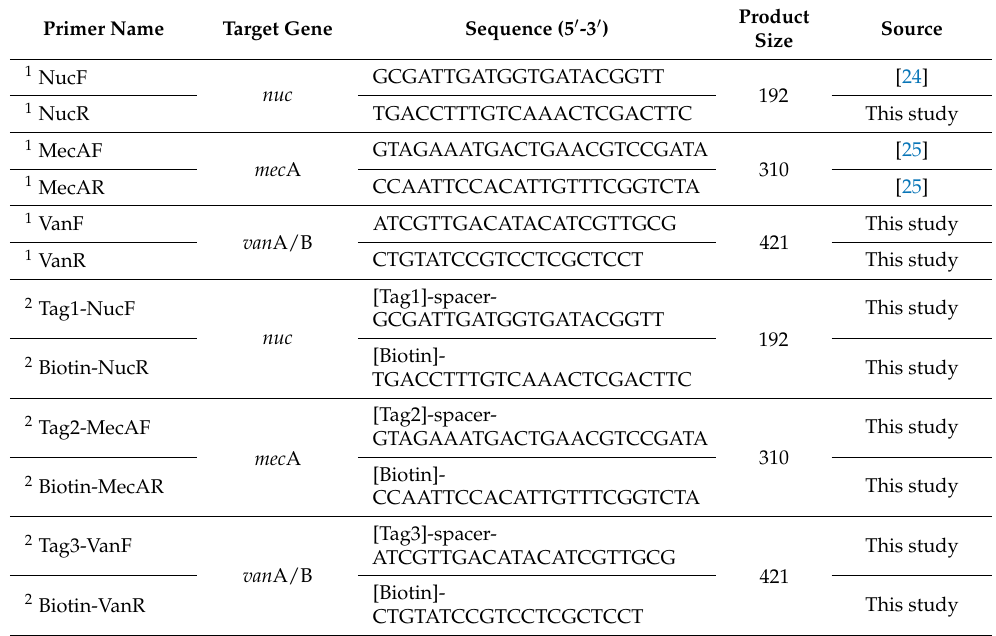
Table 1. Primers used in the study and the PCR amplicon